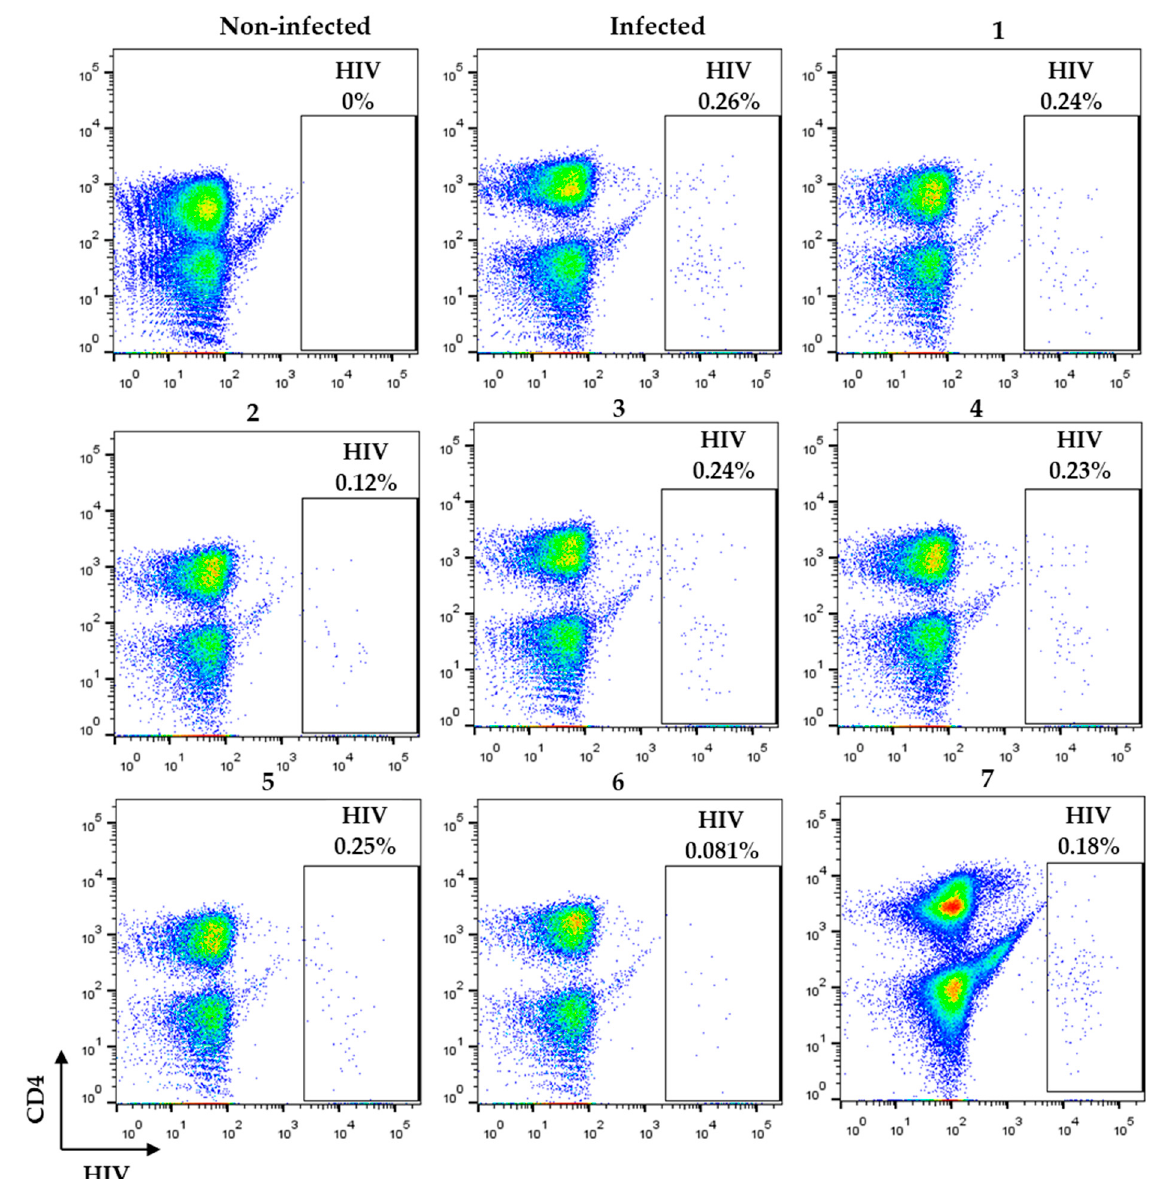
Figure 4. Frequency of HIV-1 infected primary CD4 + T cells treated with AZT-derivatives post-infection. Dot plots illustrating primary T cells HIV-1 infection levels in primary CD4 + T cells either left untreated (infected) or treated post-infection with AZT-derivatives (Infected+ compound).